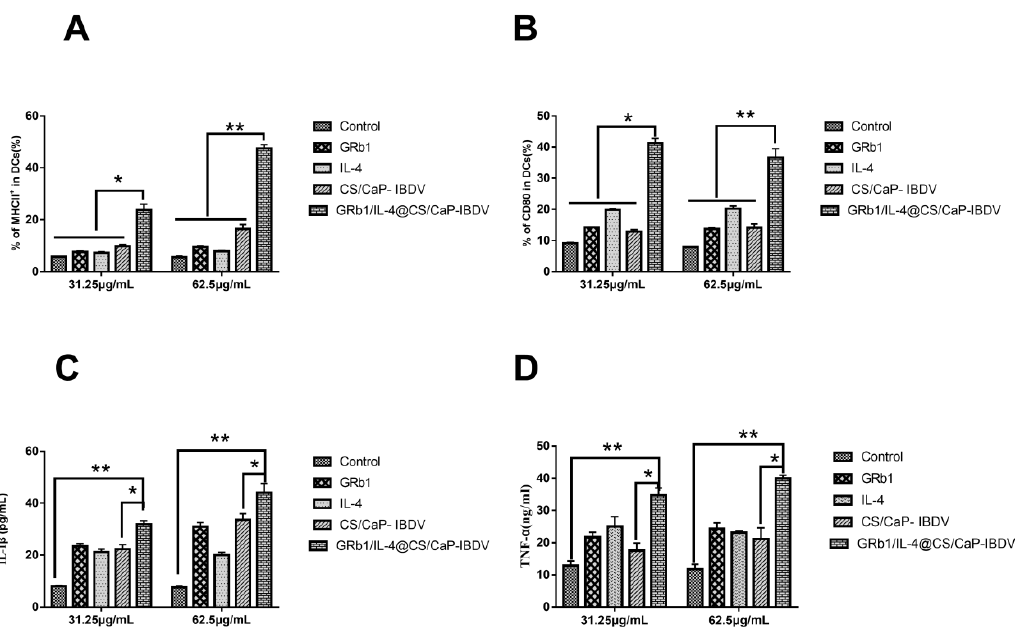
Figure 4. Effects of GRb1/IL-4@CS/CaP nanoparticles on the activation of DCs. The DCs levels of costimulatory molecules MHCII ( A ) and CD80 ( B ). The DCs-released IL-1 β ( C ) and TNF- α ( D ) levels (* p < 0.05, ** p < 0.01).